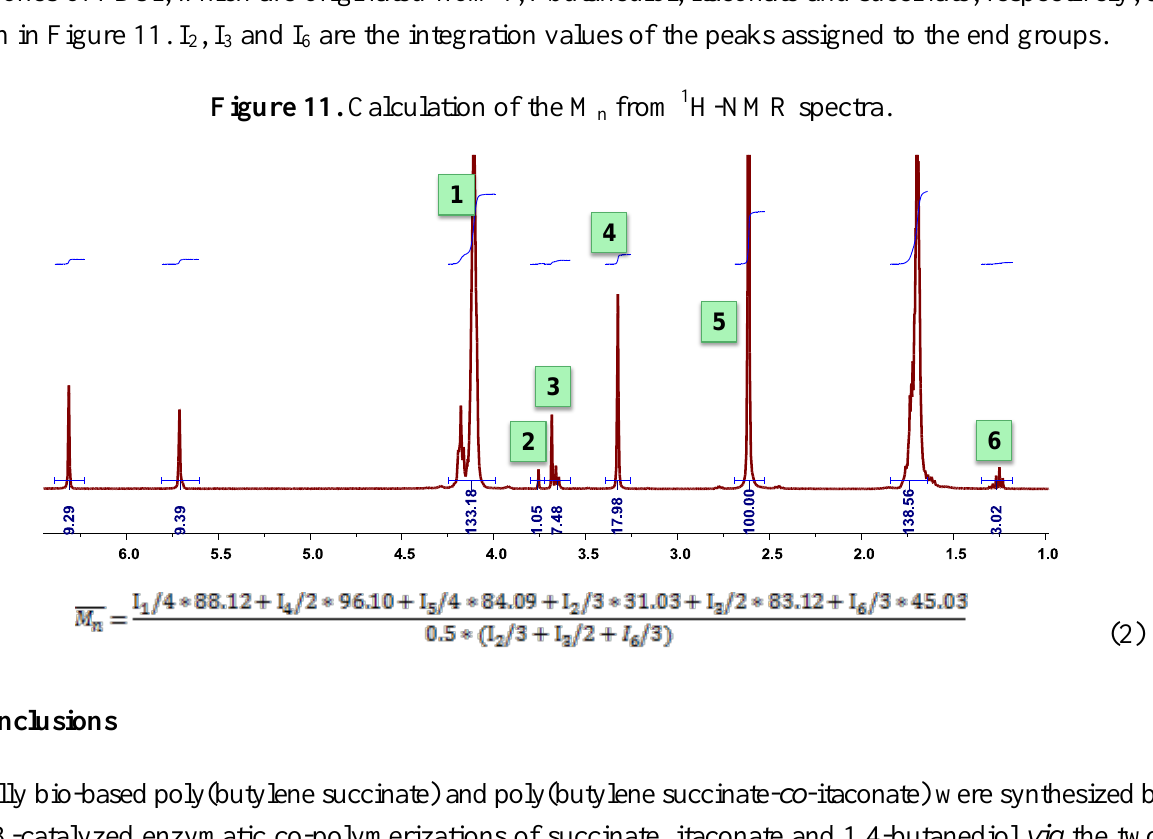
Figure 11. Calculation of the M